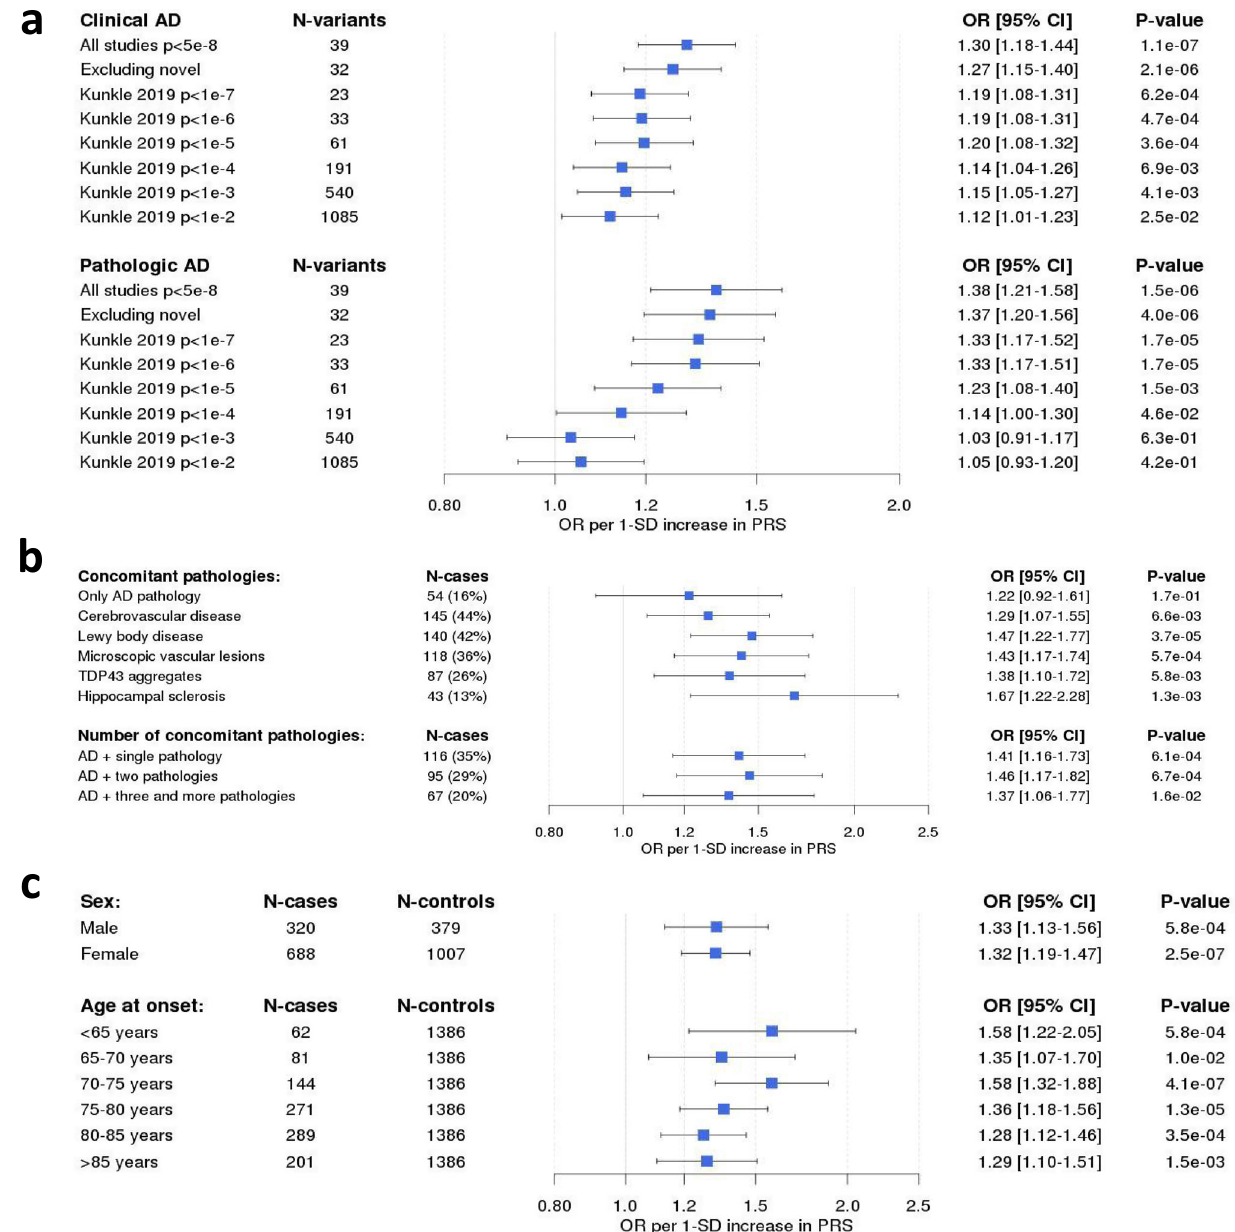
Fig. 4 Polygenic risk scores for AD. a The 39-SNP PRS association with clinical (OR = 1.30, 95% CI [1.18 – 1.44], p = 1.1×10 − 7 ) and pathologically con fi rmed AD cases (OR = 1.38, per 1-SD increase in the PRS, 95% CI [1.21 – 1.58], p = 1.5× 10 − 6 ) from EADB – F.ACE/BBB dataset. b PRS association with AD in the presence of concomitant brain pathologies (besides AD). c PRS association with AD strati fi ed by sex and AAO. A similar association of the PRS with AD was found in both sexes (OR males = 1.33, [1.13 – 1.56], p = 5.8× 10 − 4 vs. OR females = 1.32, [1.19 – 1.47], p = 2.5× 10 − 7 ). In ( a – c ) data are presented as Odds Ratio per 1-SD increase in PRS (95% CI). The generated PRS was validated using logistic regression adjusted by four principal